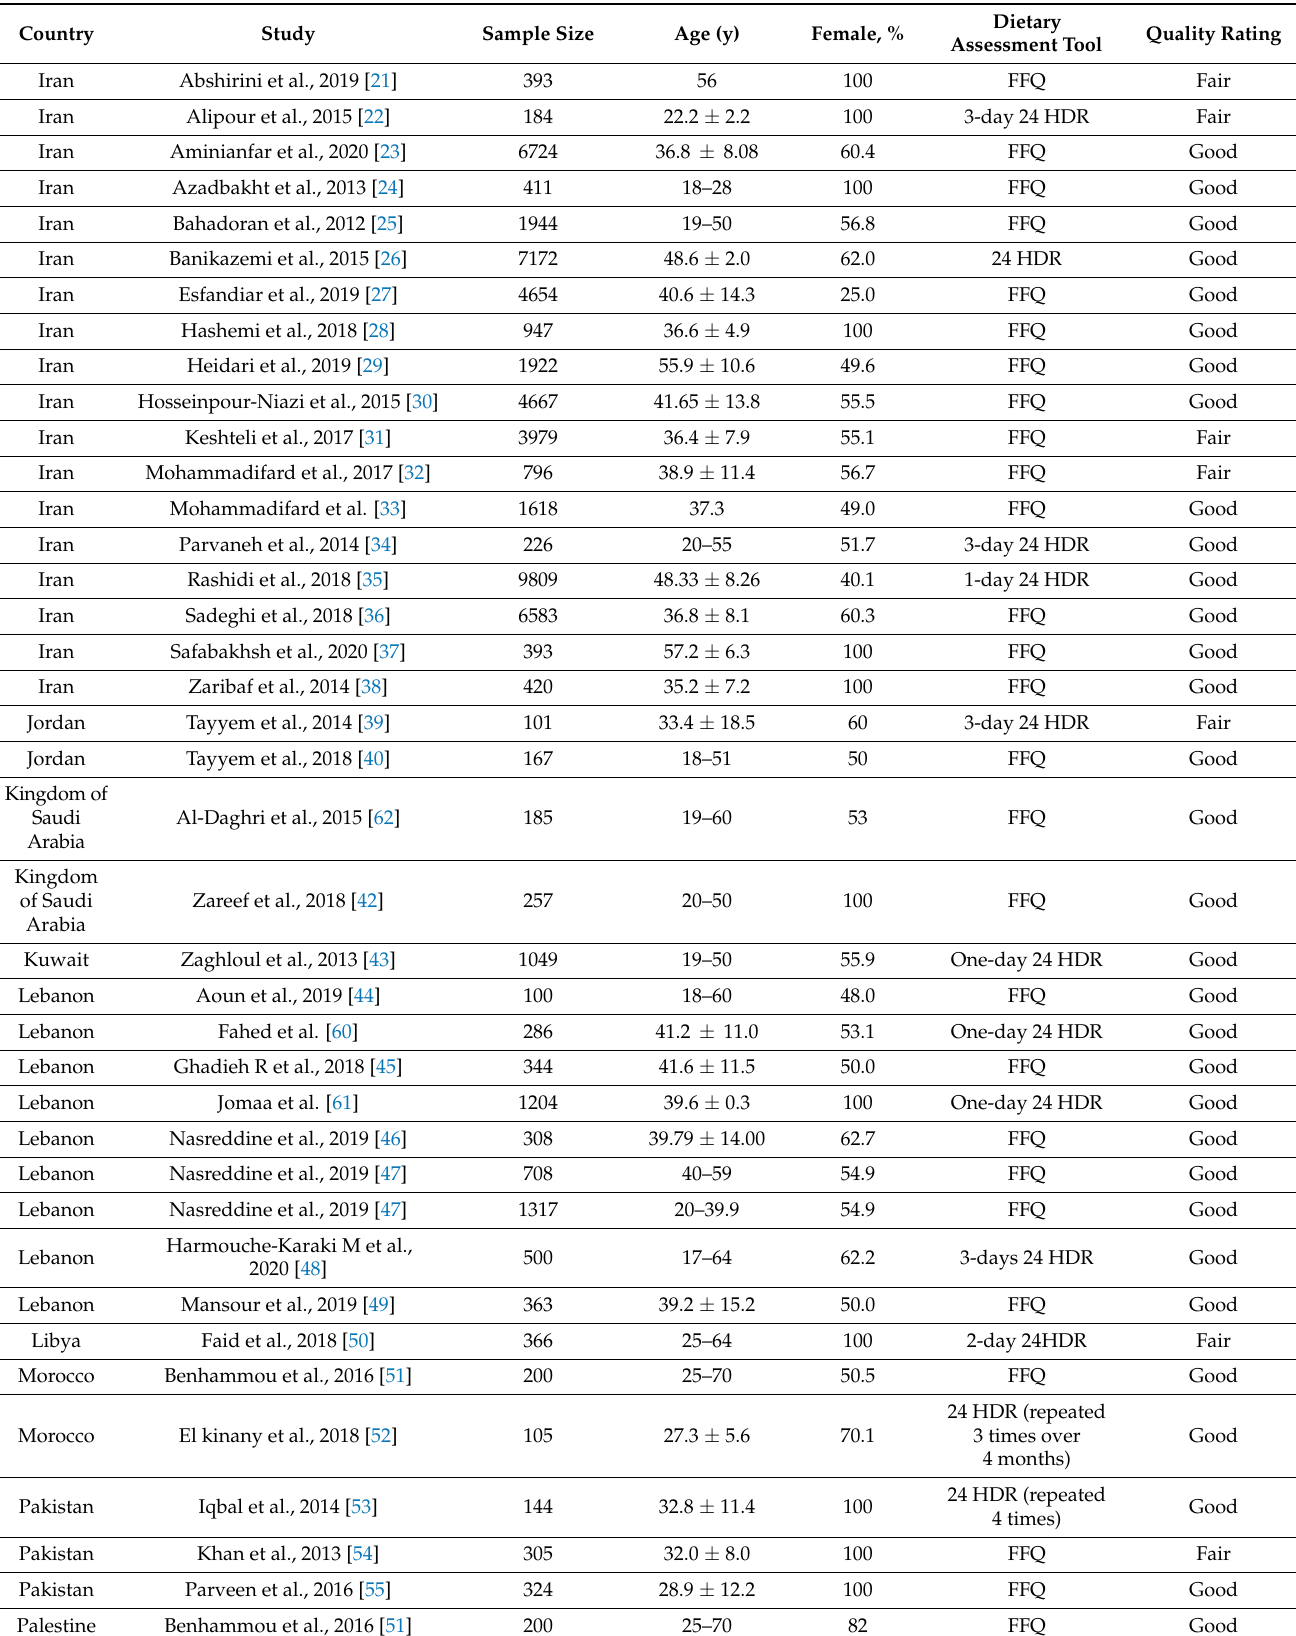
Table 2. Socio-demographic characteristics of studies included in the systematic review